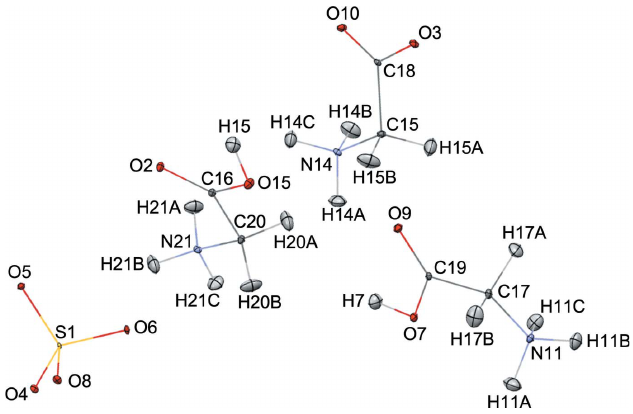
Figure 1 The molecular structure of HTGS at 20 K showing 50% displacement ellipsoids for all